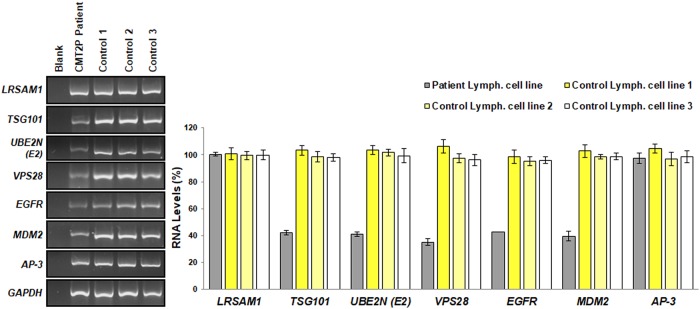
Investigation of LRSAM1 interacting molecules in the CMT2P patient lymphoblastoid cell line.(A) RNA expression analysis of most likely interacting molecules in patient and three control individuals’ samples. GAPDH was used as a housekeeping internal control. (B) Quantification of the mRNA expression levels of the molecules relative to the control samples. The average of controls 1 to 3 was set to 100. Values were obtained as ratios of the RNA of interest over GAPDH control. Specifically, the patient lymphoblastoid cell line showed significantly lower levels of TSG101 (42.21% ±1.62%, p<0.0007), UBE2N (40.94%±1.90%, p<0.005), VPS28 (35.14%±2.62%, p<0.001), EGFR (42.58%±0.21%, p<0.003) and MDM2 (39.44%±3.55%, p<0.0008) than the control samples. In contrast AP-3 (97.34%±3.98%, p<0.104) showed similar expression between the patient and control samples. Amplification of each primer set was repeated in triplicate.